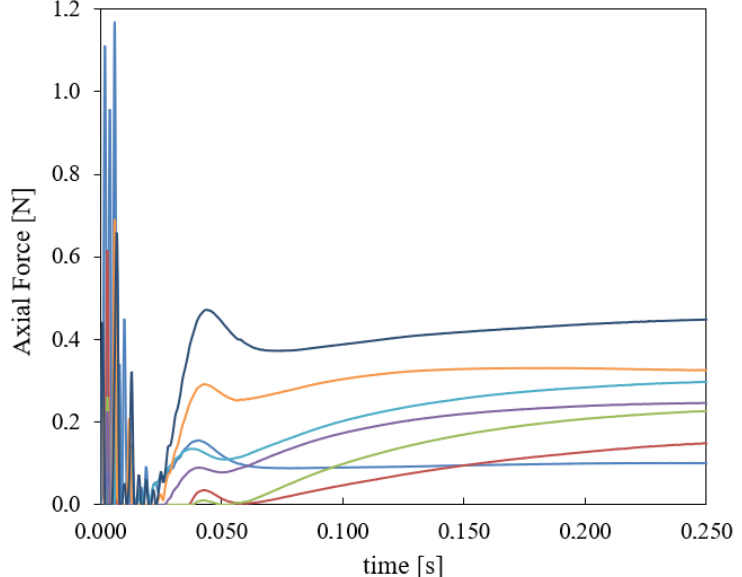
Figure 5. Axial Forces on the CBVs of the SIMon model (FEHM), computed for the described fall from a height of 2.5 m against a ground of ballast stiffness k b = 40 N/cm 3 . One line is presented for each pair of CBVs of the FEHM. Each color line represents a different CBV, the forces differ because the CBVs are located in different parts of the